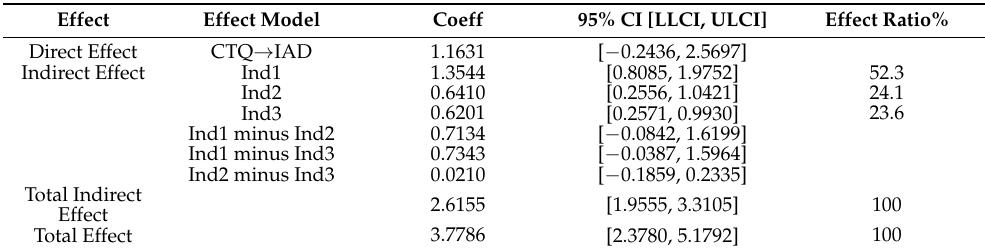
Table 3. The chain-mediated effects of childhood trauma on Internet addiction and bias-corrected 95% confidence intervals.